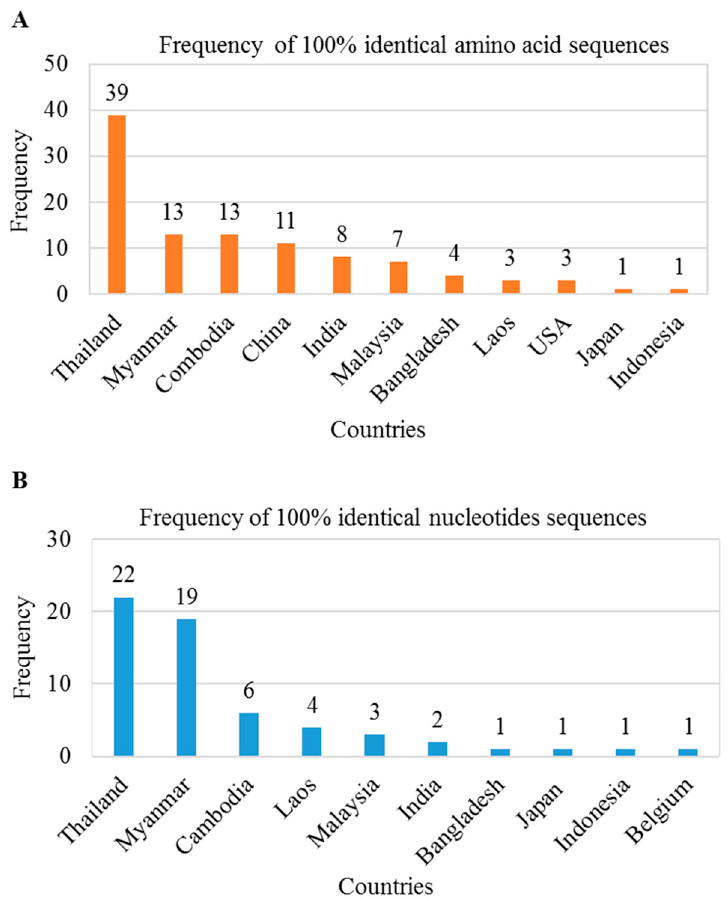
Figure 5. Distribution of silent large HBsAg mutated HBV in Asiatic countries. BLAST searches were performed using 119 amino acids / 357 nt of the preS1 region of BD2 genome. A total of 103 amino acid sequences ( A ) and 60 nucleotide sequences ( B ) showed 100% sequence identity.